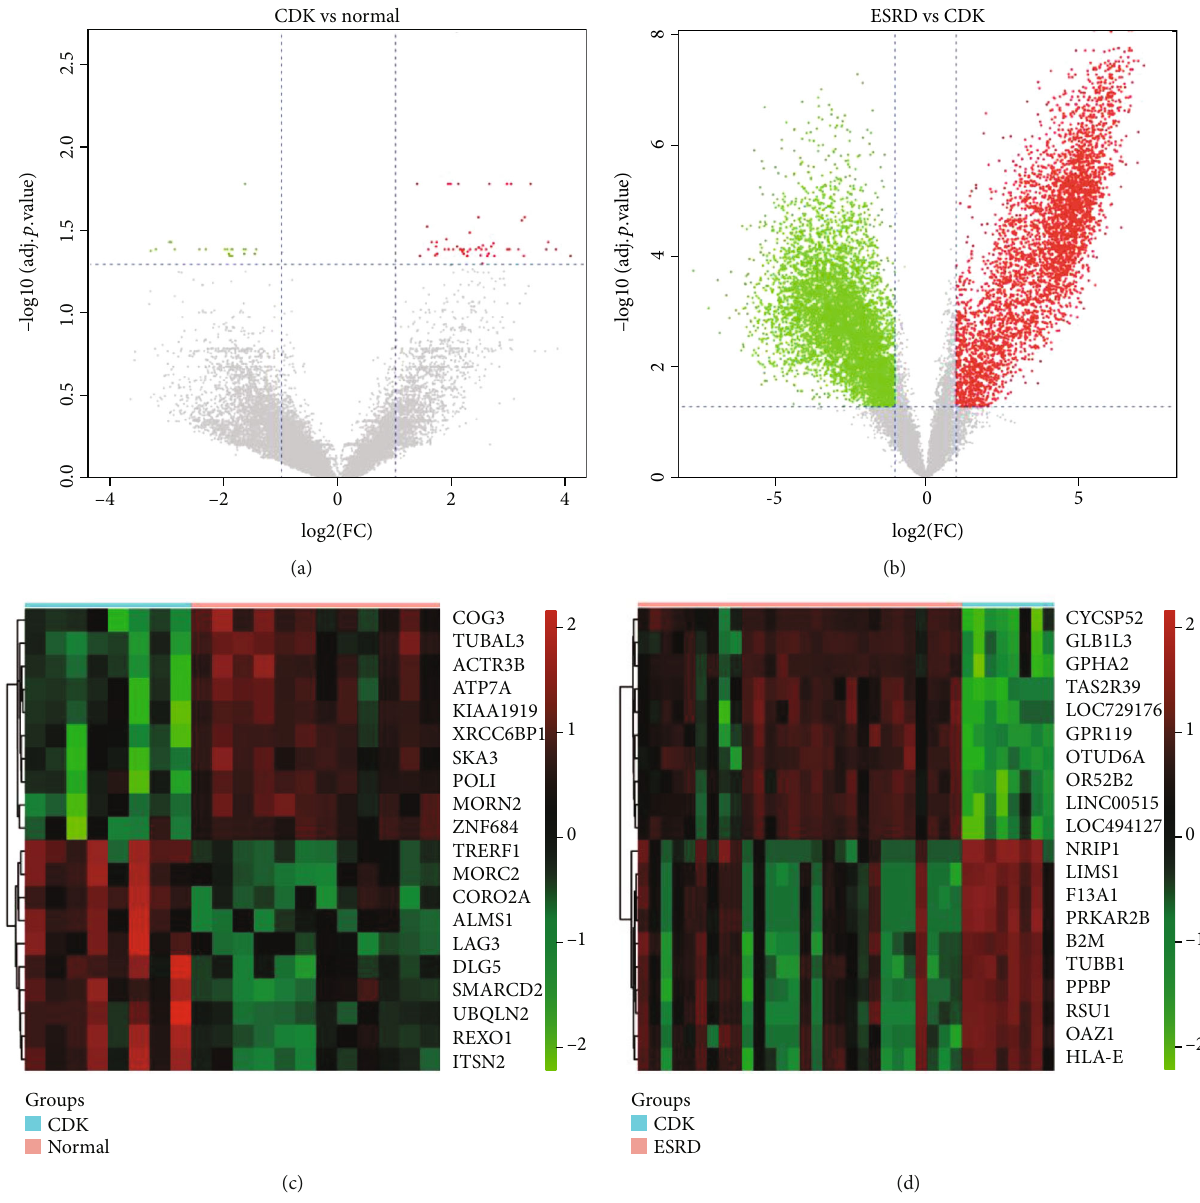
Figure 1: The volcano map and clustering analysis for the identi fi cation of di ff erentially expressed genes in kidney disease. (a, b) The volcano maps were used to visualize the di ff erential expressed genes between CDK vs. Normal and ESRD vs. CDK samples. The adjusted p value ≤ 0.05 and ∣ logFC ∣ ≥ 1 were considered as thresholds. Red dots represent upregulated gene while green dots represent downregulated genes. (c, d) The clustering analysis results were visualized in a heat map to identify the top 10 di ff erential expressed genes between di ff erential groups (CDK vs. Normal and ESRD vs.